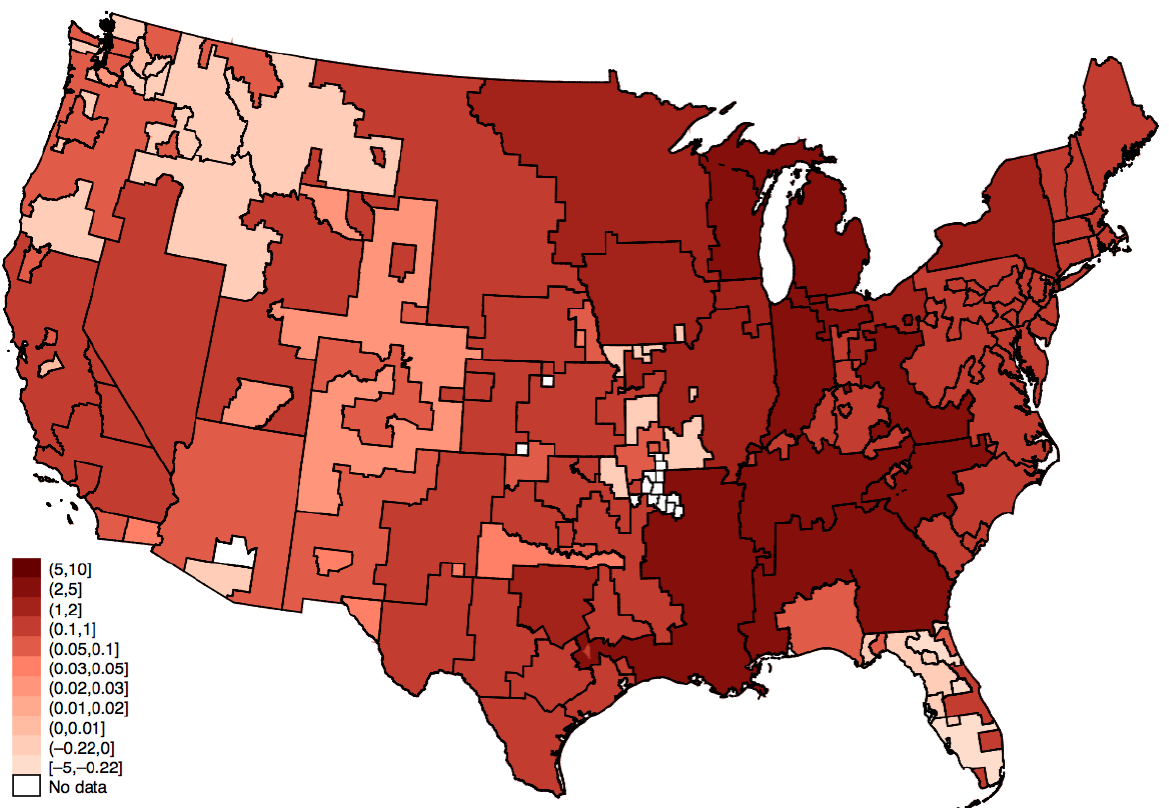
Figure A7. Reduction in deaths: electricity. Notes: Figure shows monthly reduction in expected deaths from reduced electricity consumption in each